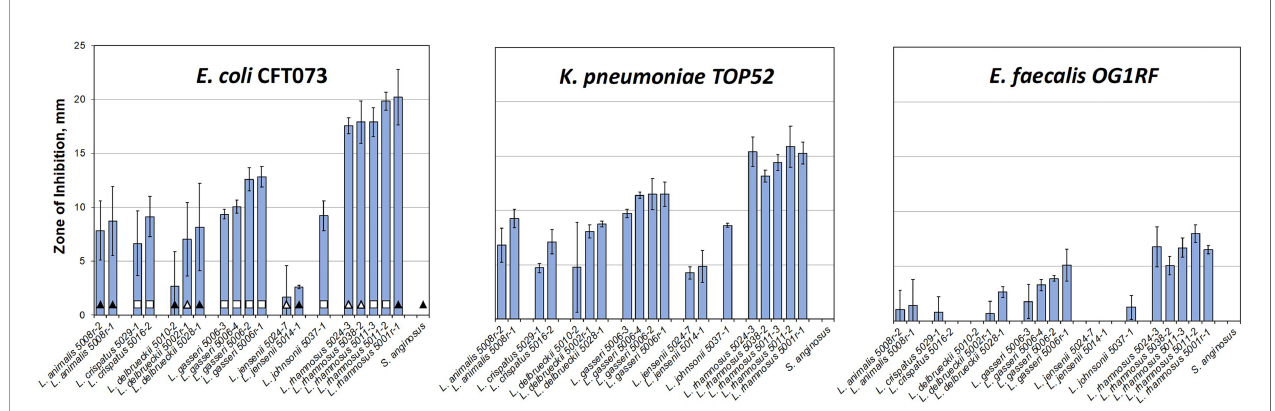
FIGURE 2 | Majority of urinary lactobacilli exhibit varying degrees of inhibition of major uropathogens. Twenty strains of urinary commensal lactic acid bacteria (lactobacilli and one strain of Streptococcus anginosus as a control) were tested against model uropathogenic strains: E. coli CFT073, K. pneumoniae TOP52, and E. faecalis OG1RF. Bars indicate the standard deviation of three replicates. The leftmost plot carries identi fi cations of the patient cohorts for each strain ( Table S3 ): empty square – no UTI; black triangle – rUTI; white triangle – rUTI with prophylactic antibiotics. The data are presented by species alphabetically and sorted by the inhibition against CFT073 within species